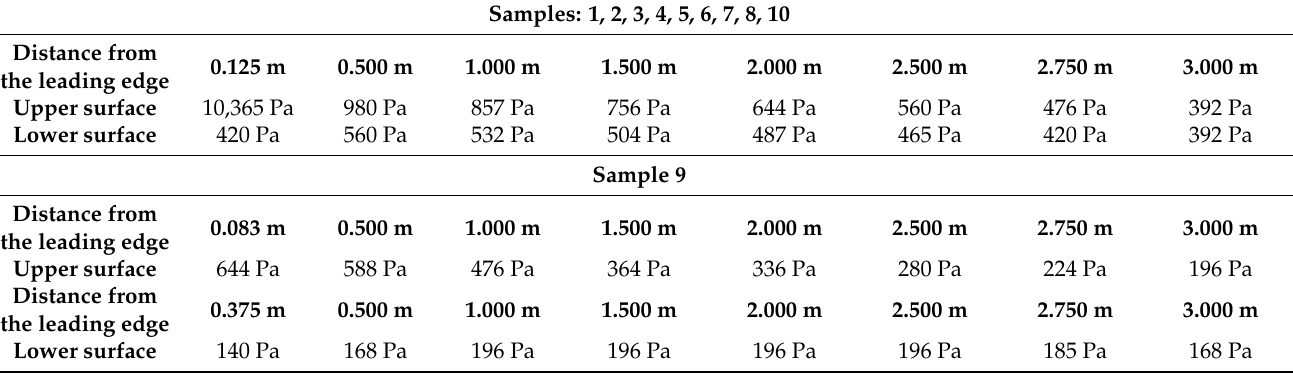
Table 5. Pressure difference changes on the upper and lower surfaces of the considered materials in the symmetry plane.